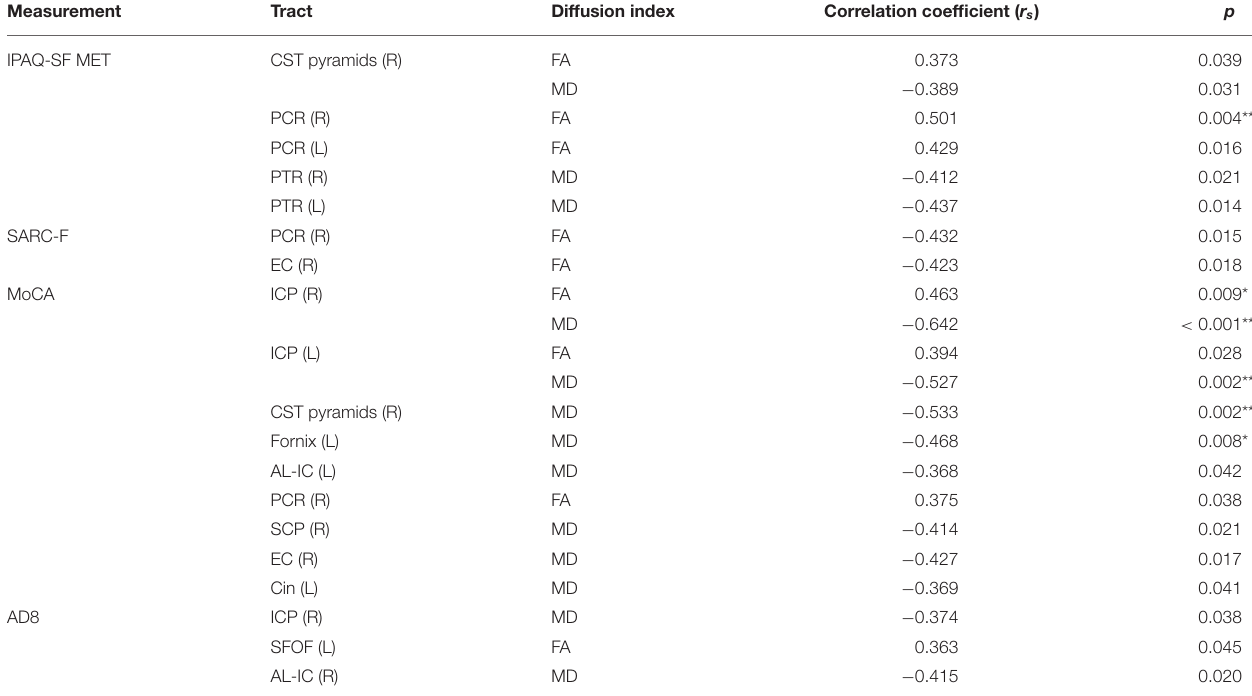
TABLE 2 | Correlations of clinical and diffusion indices in SCD ( N = 31), significance at p < 0.05. Measurement Tract Diffusion index IPAQ-SF MET